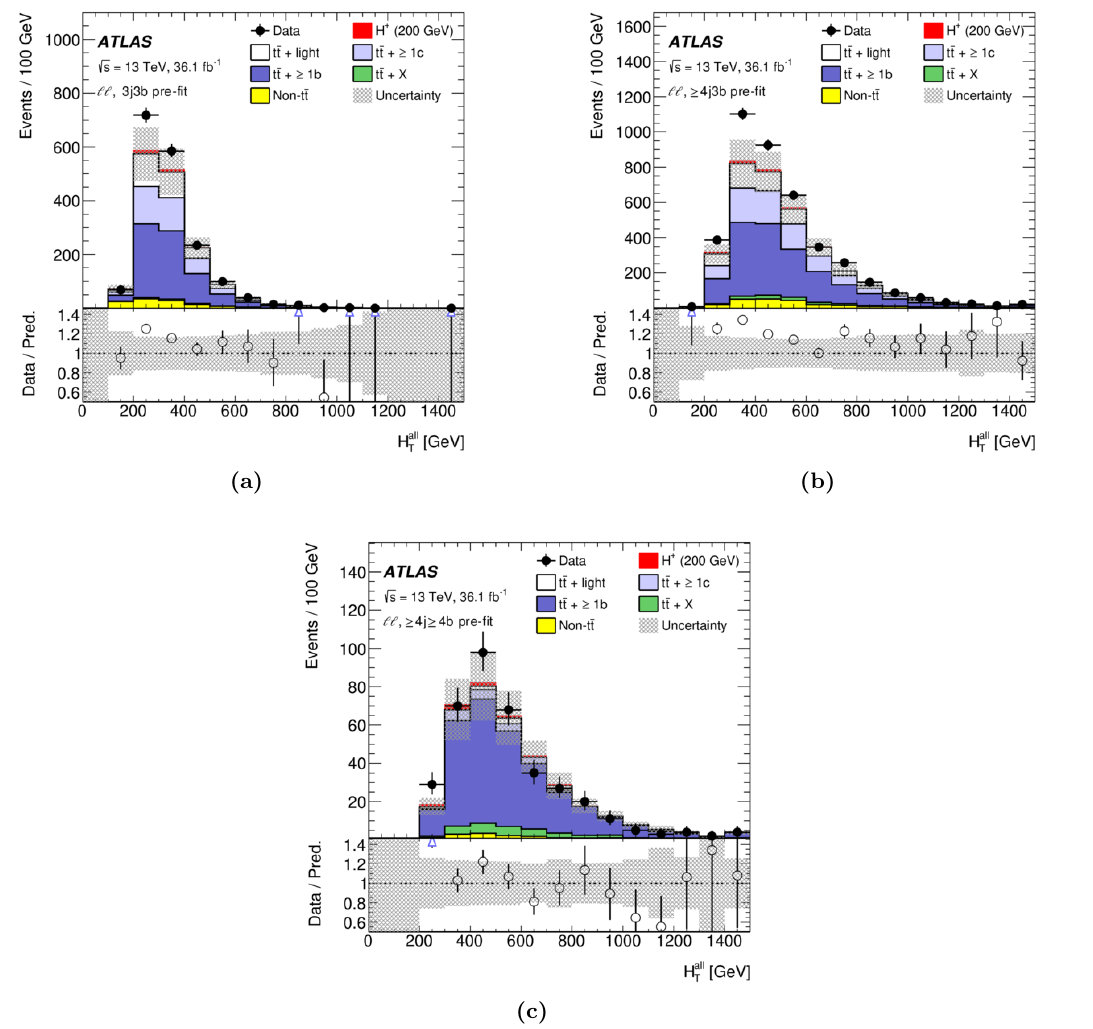
Figure 4. Distributions of the H all variable before the (cid:12)t to the data in the three SRs of the ‘‘ T channel: (a) 3j3b, (b) (cid:21) 4j3b and (c) (cid:21) 4j (cid:21) 4b. Each background process is normalised according